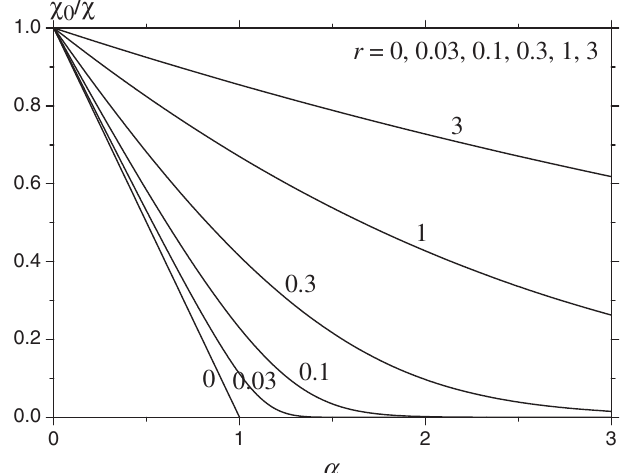
FIG. 3. Reduced inverse susceptibility as a function of (cid:3) for different r